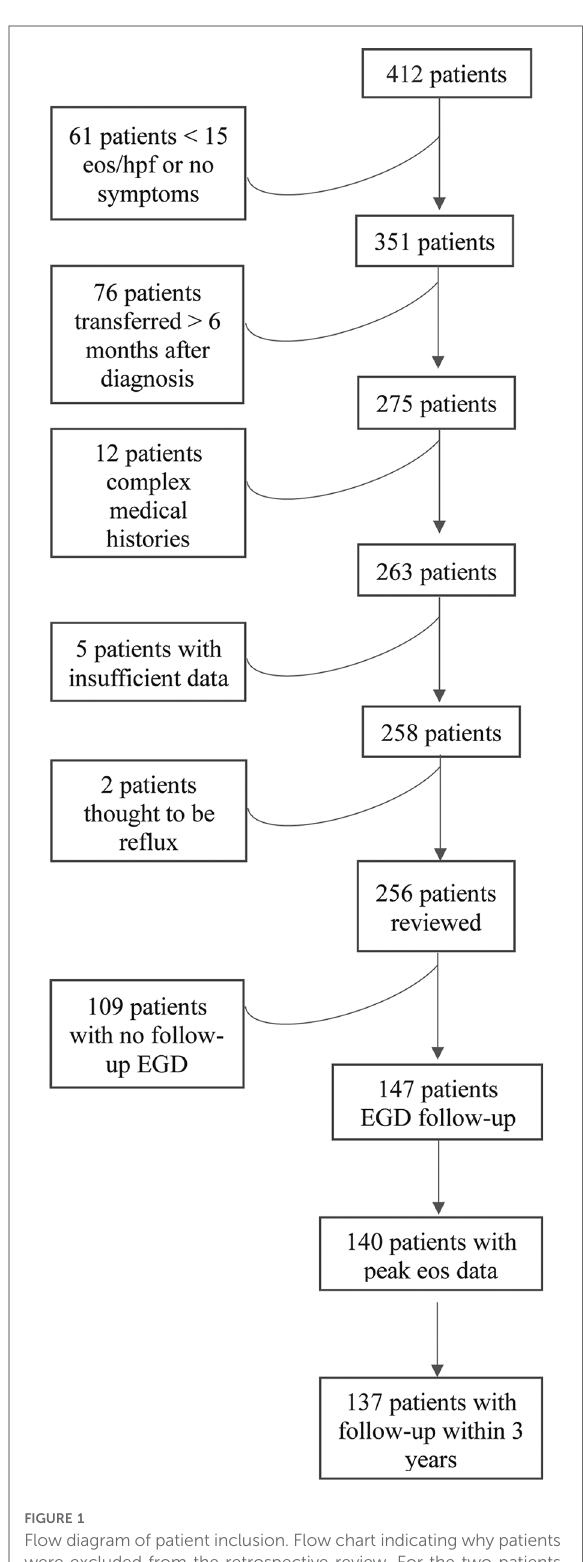
FIGURE 1 Flow diagram of patient inclusion. Flow chart indicating why patients were excluded from the retrospective review. For the two patients excluded by clinician review, the peak eosinophils/hpf were 15 and 16, respectively, and the patients had mild symptoms that improved with anti-re fl ux